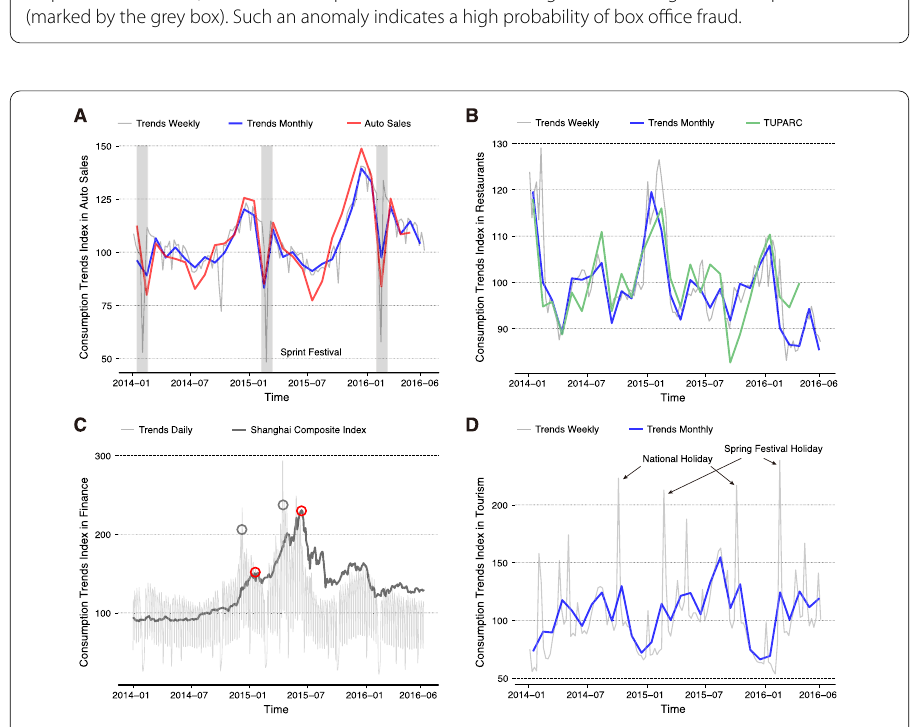
Figure 10 Consumption trends for various industries in the service sector. All indices are normalized by the mean value for the year 2014. (A) Auto sales. (B) Restaurants. (C) Finance & Investments. We mark the ‘turning point’ in stock market and map query data with circles, which indicate that map queries may be a leading indicator for stock market movements. (D) Tourism. Important holidays are labelled with